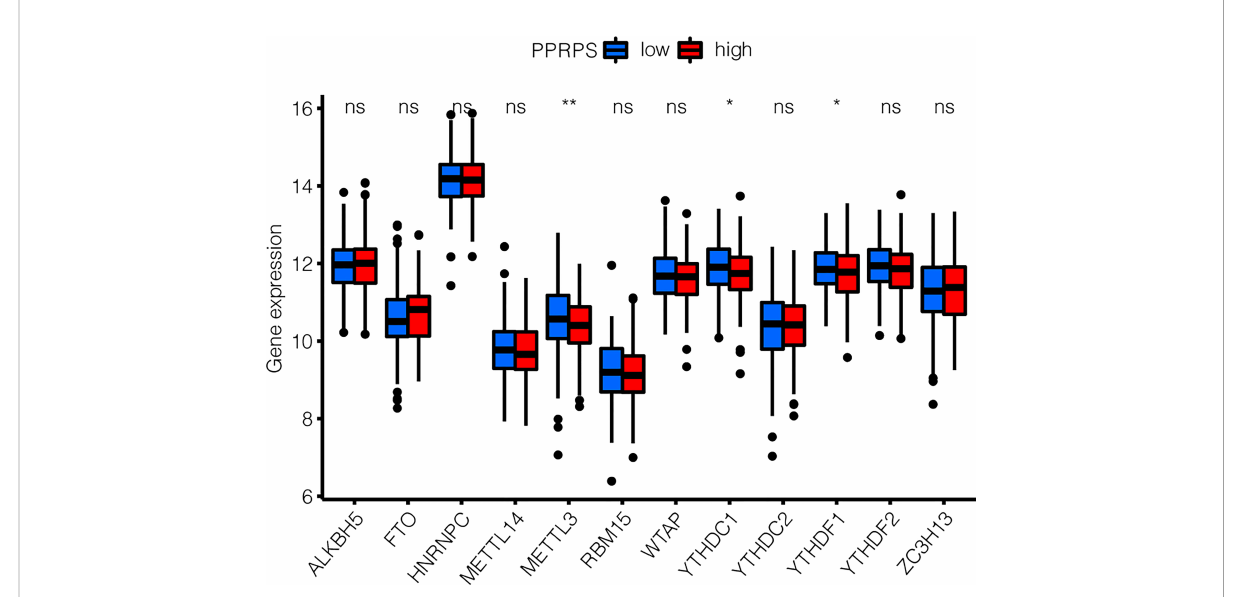
FIGURE 7 m6A-related DEG patterns between low- and high-PPRPS bladder cancer patients. The expression of 12 m6A-related genes was evaluated within the low- and high-PPRPS groups. *p < 0.05, **p < 0.01, ns, not signi fi cant.